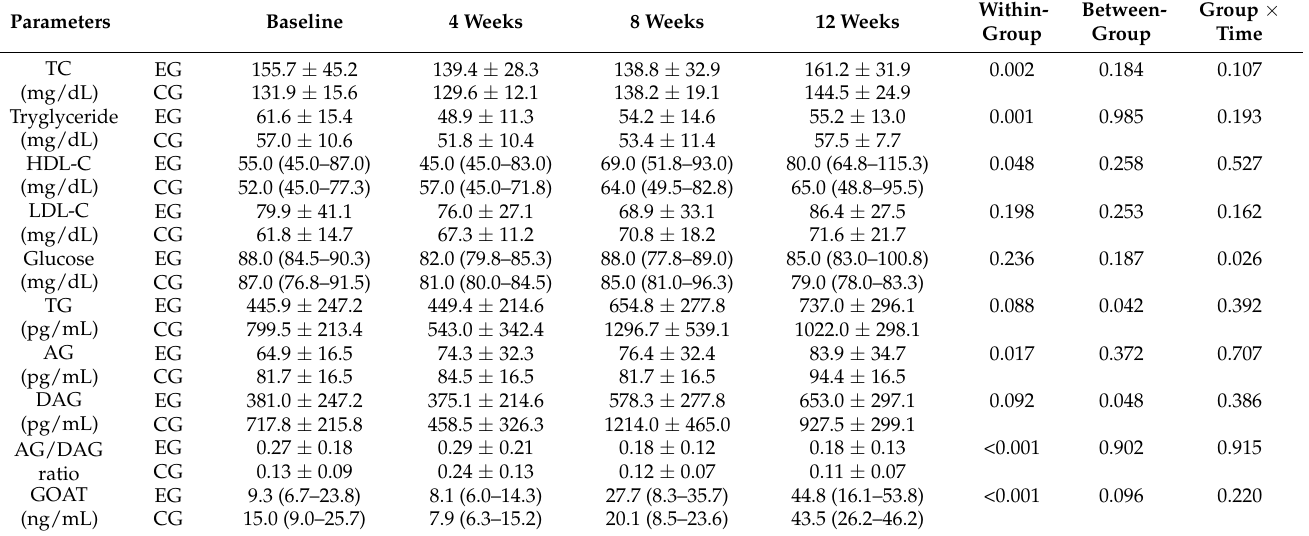
Table 3. Changes in the metabolic parameters of the two